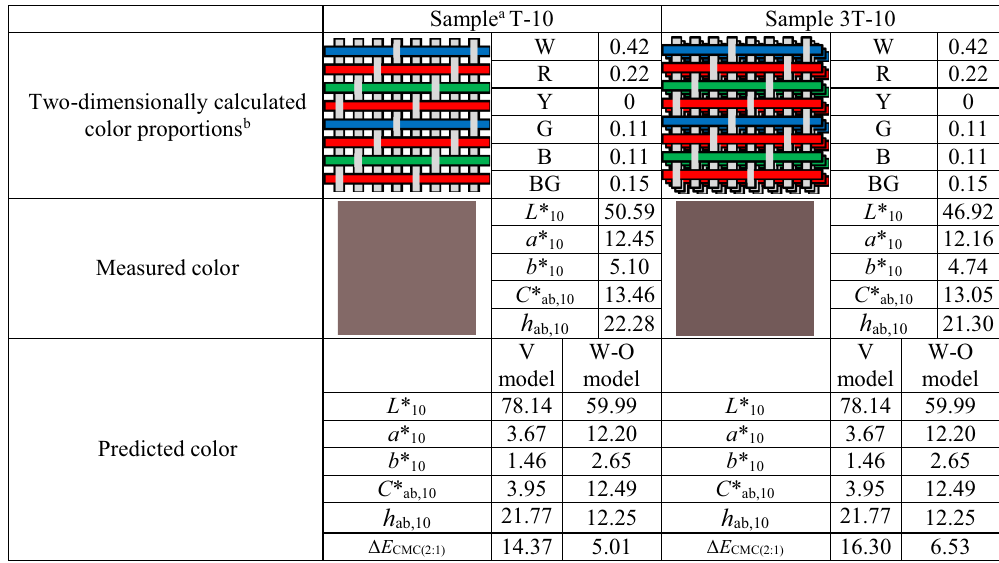
Table 2. Comparison of color measurement results and two-dimensional color prediction results for two test samples with the same face layer. a Sample. Weave (T: 1/3 twill)—Weft color arrangement (see Table 1; 10: RGRBRGRB). b Two-dimensionally calculated color proportions. W = white yarn (warp); R = red yarn (weft 1); Y = yellow yarn (weft 2); G = green yarn (weft 3); B = blue yarn (weft 4); BG = background (white